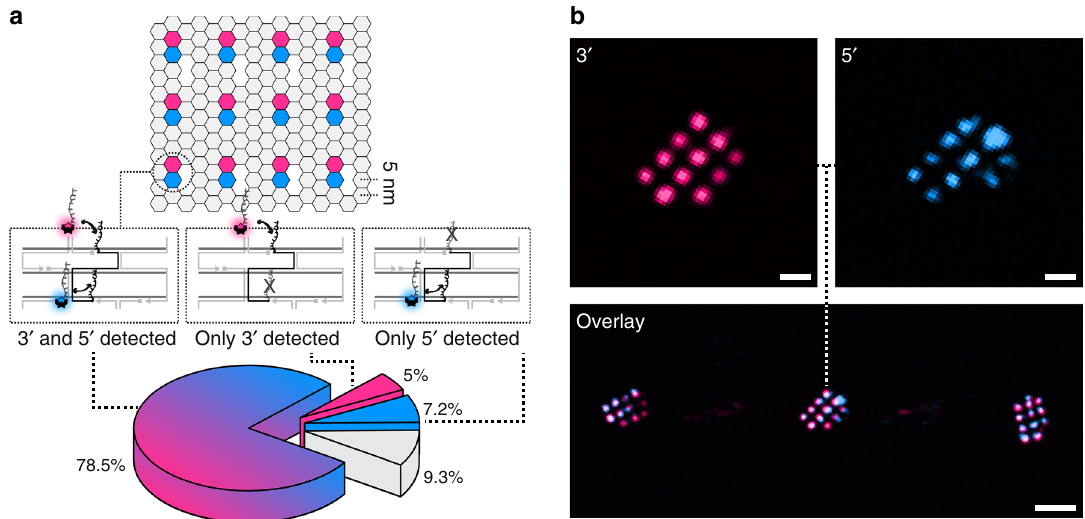
Fig. 2 Experimental validation of accessibility and incorporation ef fi ciency. a The 20-nm-grid staples were extended with orthogonal DNA-PAINT docking sites on the 3 ′ -end (magenta) and 5 ′ -end (blue) and subsequently imaged using Cy3B-(magenta) and Atto647N-labeled (blue) imager strands. The pie chart shows the percentage of docking sites where both ends were detected (blue to magenta slice), only the 3 ′ -end (magenta slice), only the 5 ′ -end (blue slice), and no end was detected at all (gray slice). b Overlay and color-separated zoom-ins of the two-color DNA-PAINT measurement. Scale bars: 20 nm in b (top), 100 nm in b (bottom)